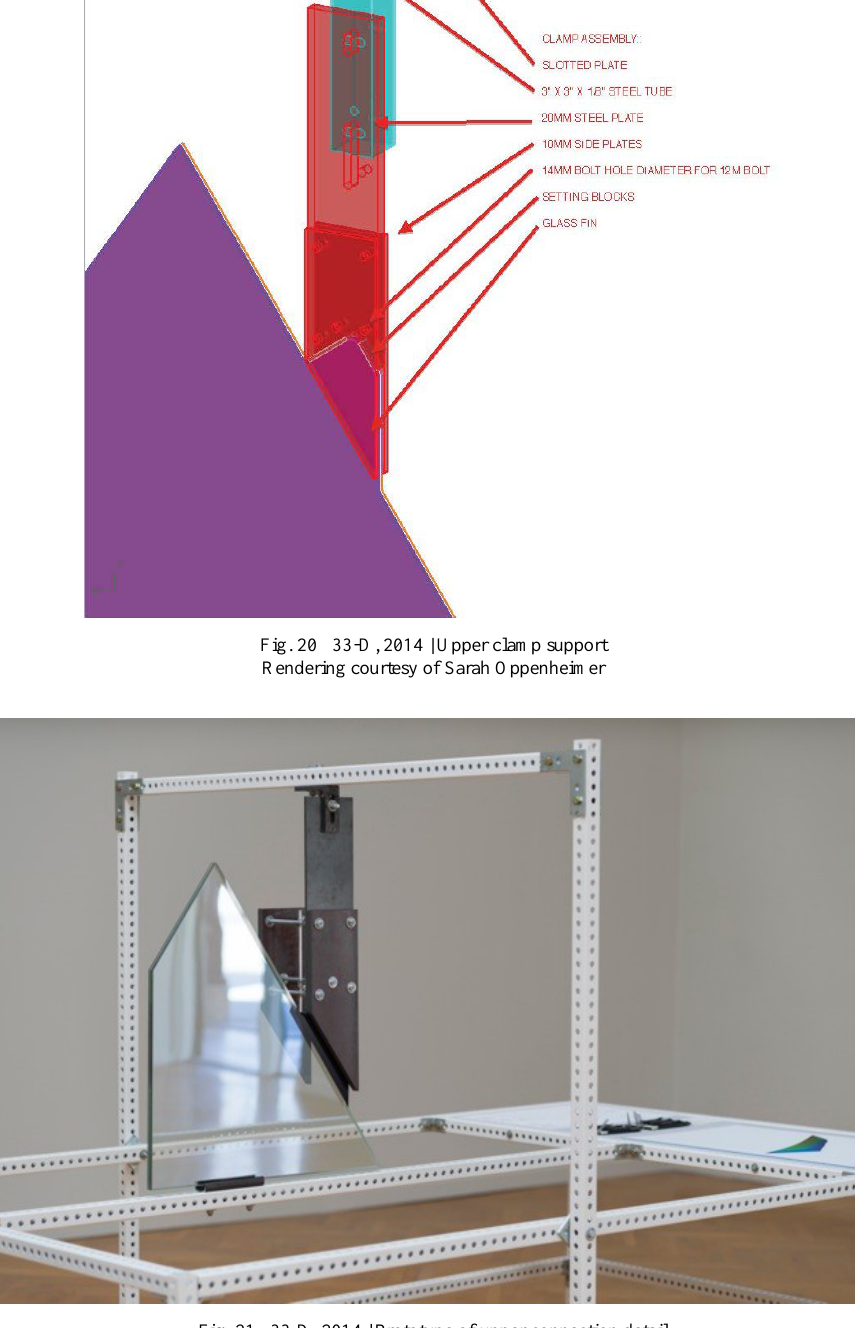
Fig. 21 33-D, 2014 | Prototype of upper connection detail Photo courtesy of Sarah